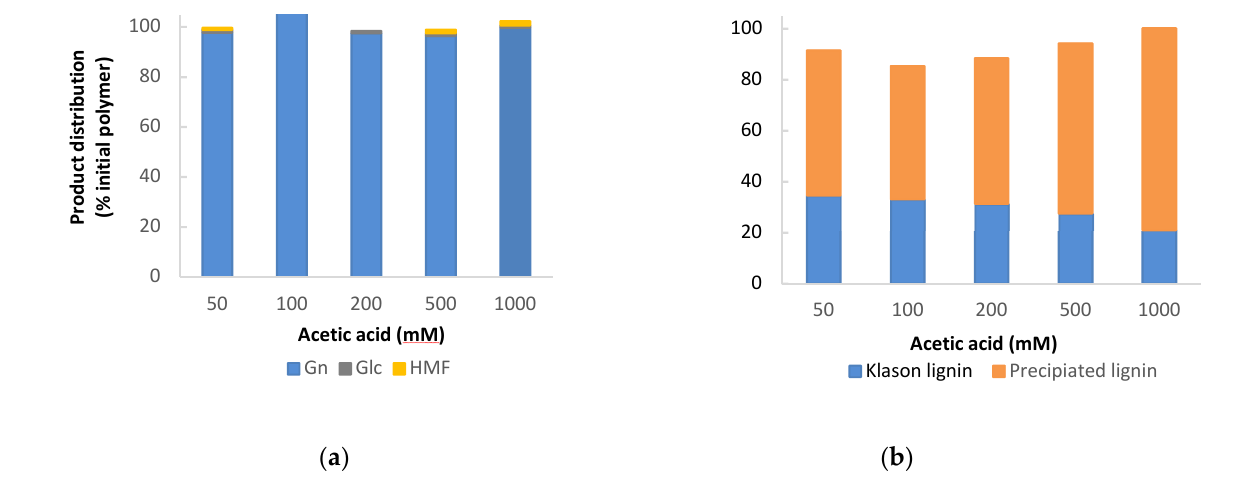
Figure 4. Product distribution obtained for eucalyptus residues (ER) using ethanol-based organo- solv fractionation (acetic acid added as catalyst, 190 °C, 120 min) for glucan ( a ) and lignin ( b ). Abbreviations are as in caption of Figure 2.